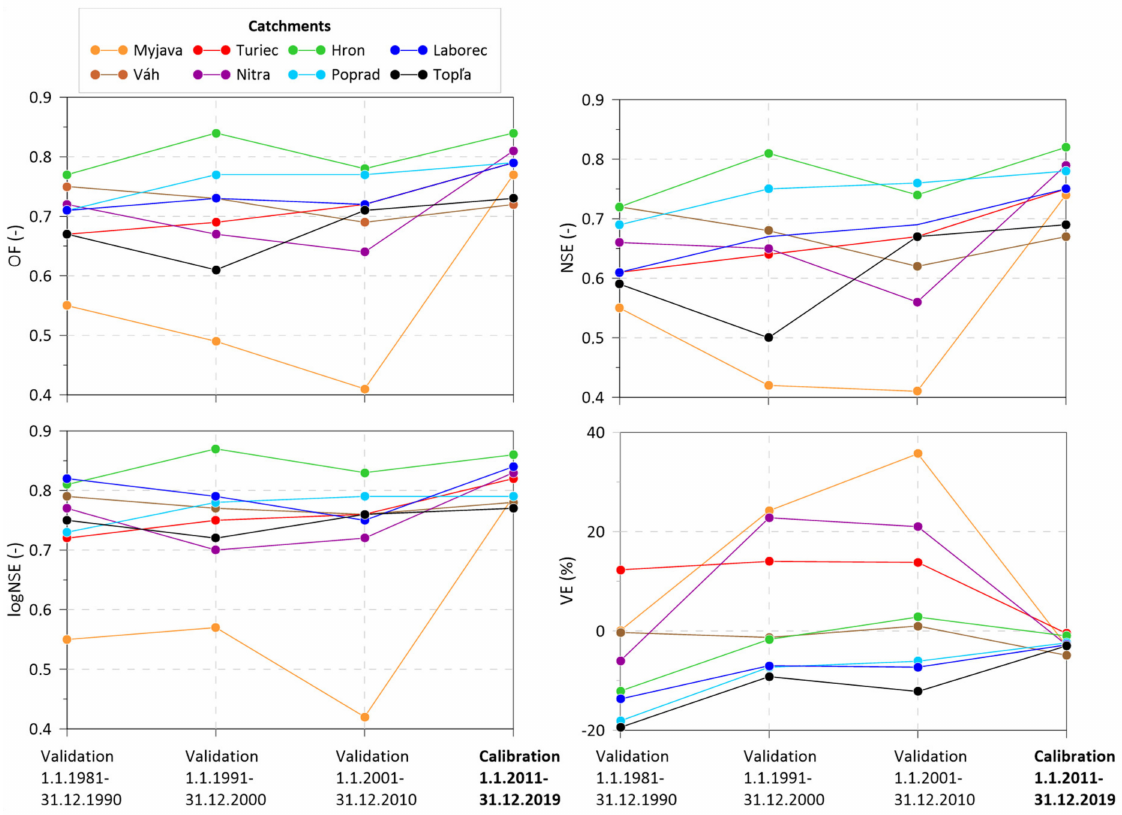
Figure 4. Values of the objective function ( OF ), the logarithmic Nash–Sutcliffe efficiency ( logNSE ), the Nash–Sutcliffe efficiency ( NSE ), and the volume error ( VE ) in the calibration/validation periods of the eight basins